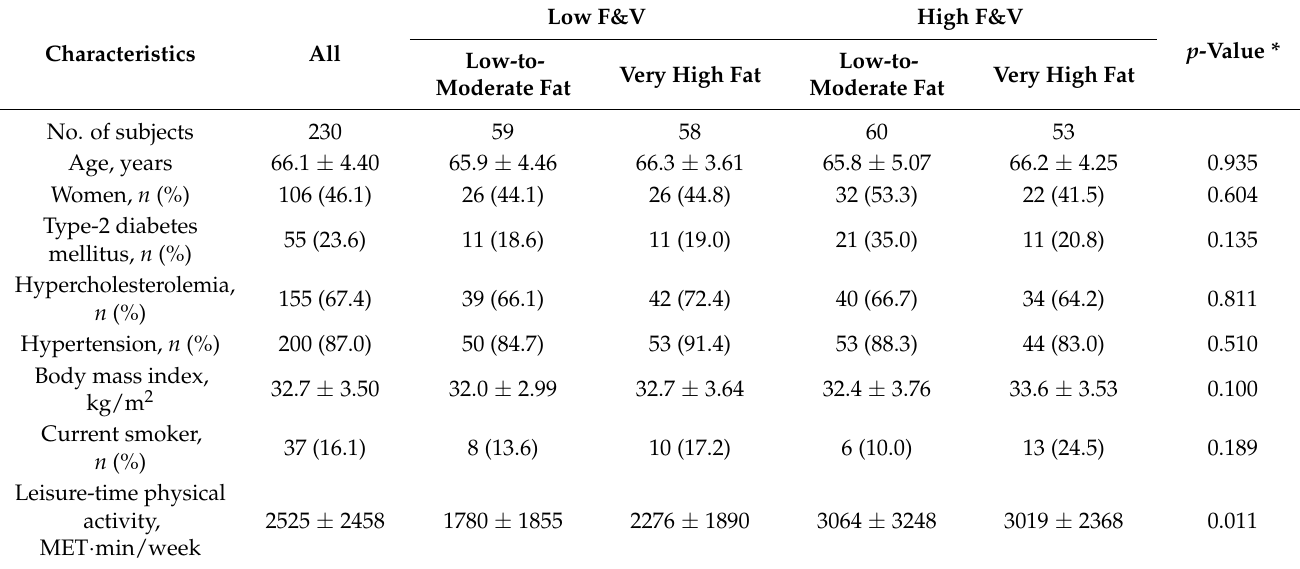
Table 1. Participant characteristics by Fruit and Vegetable and Fat Intake